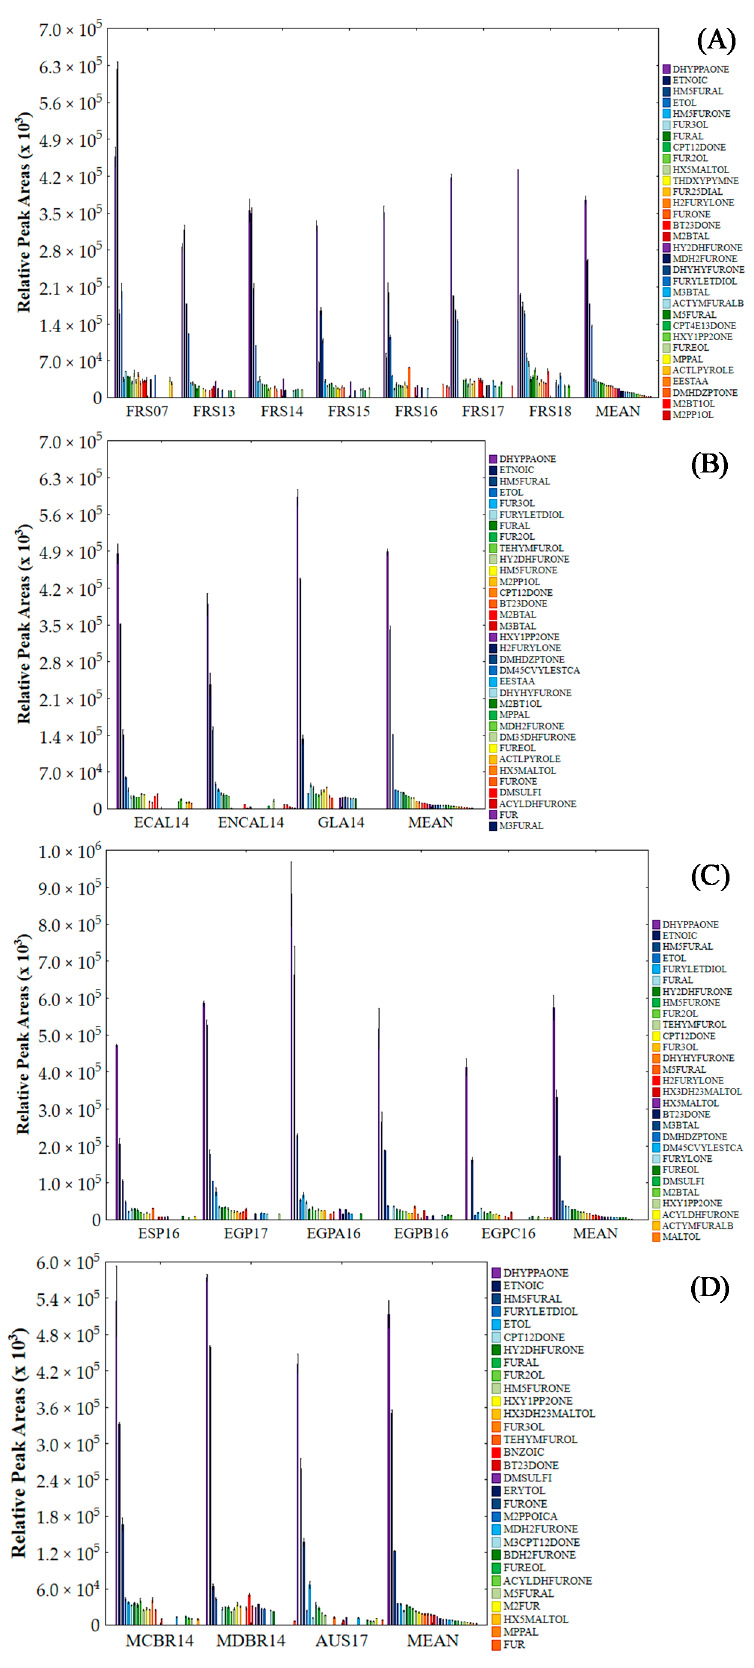
Figure 1. The relative peak area values of the 20 main VOCs for samples of CERT group ( A ), NCERT group ( B ), MED group ( C ) and STH group ( D ).